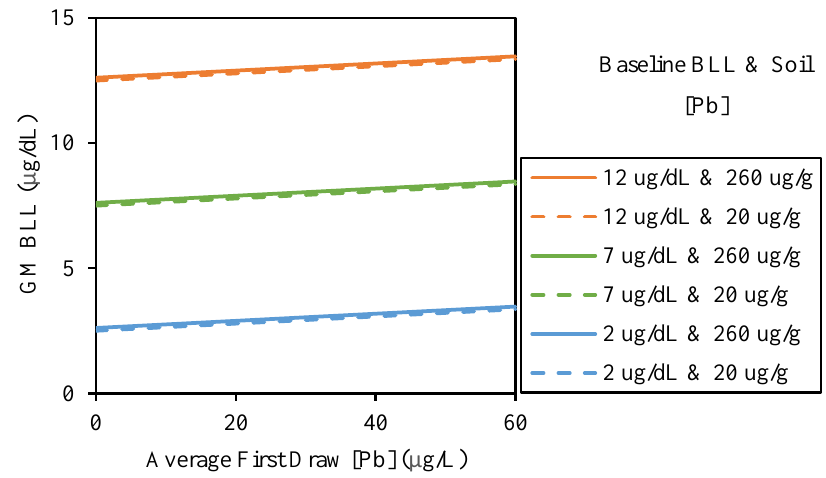
Figure 9. Predicted geometric mean BLL as a function of the secondary school average first draw drinking water lead concentration, the baseline BLL, and the region’s soil lead concentration according to bowers’ model.